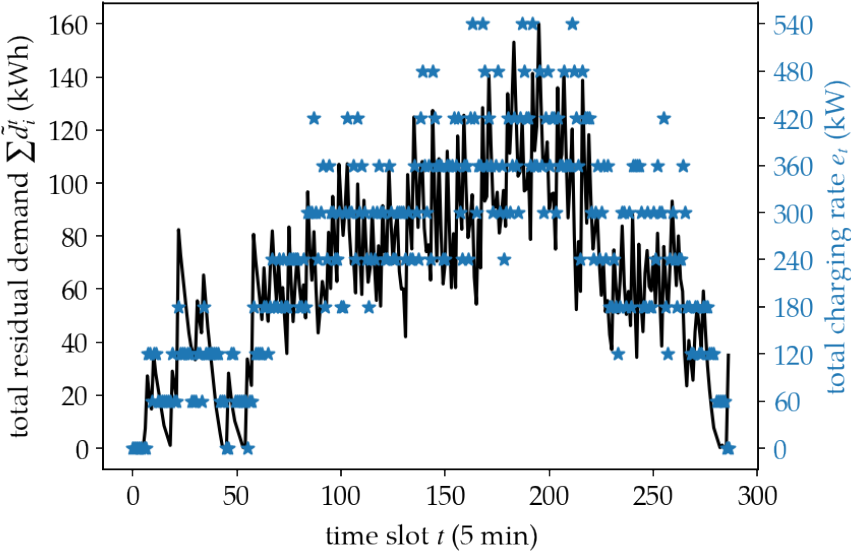
Figure 12. Total residual demand vs. total charging